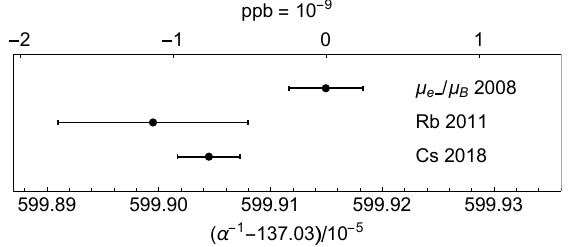
Figure 4. Most accurately determined values of the fine structure constant. No other determinations have uncertainties small enough to fit on this